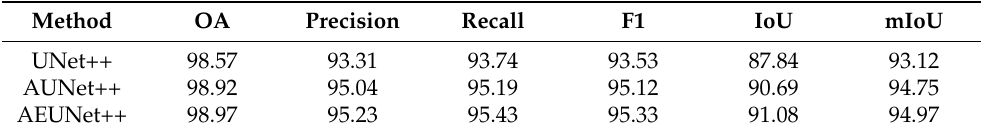
Table 3. Ablation comparison of OA, Precision, Recall, F1, IoU and mIoU for the WHU aerial image data